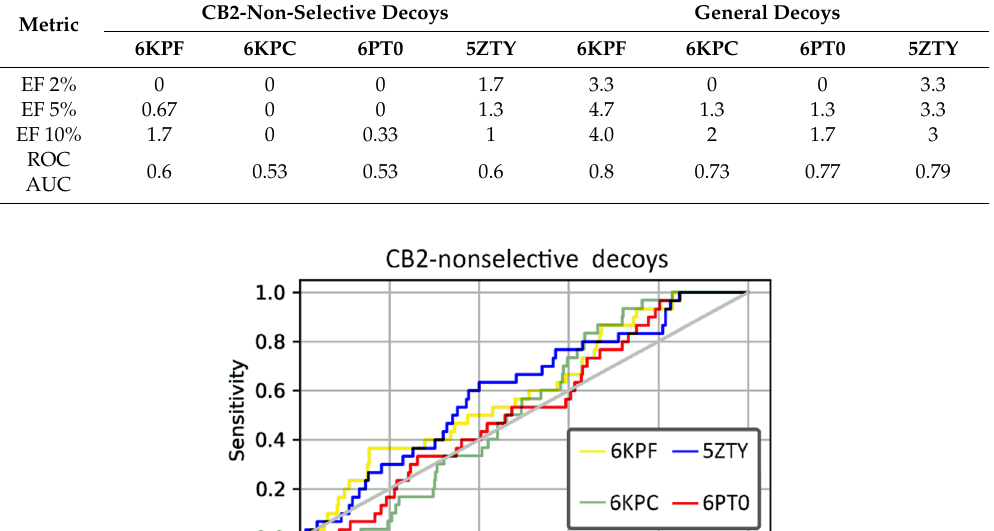
Table 2. Results of the enrichment study for CB2-receptor structures.